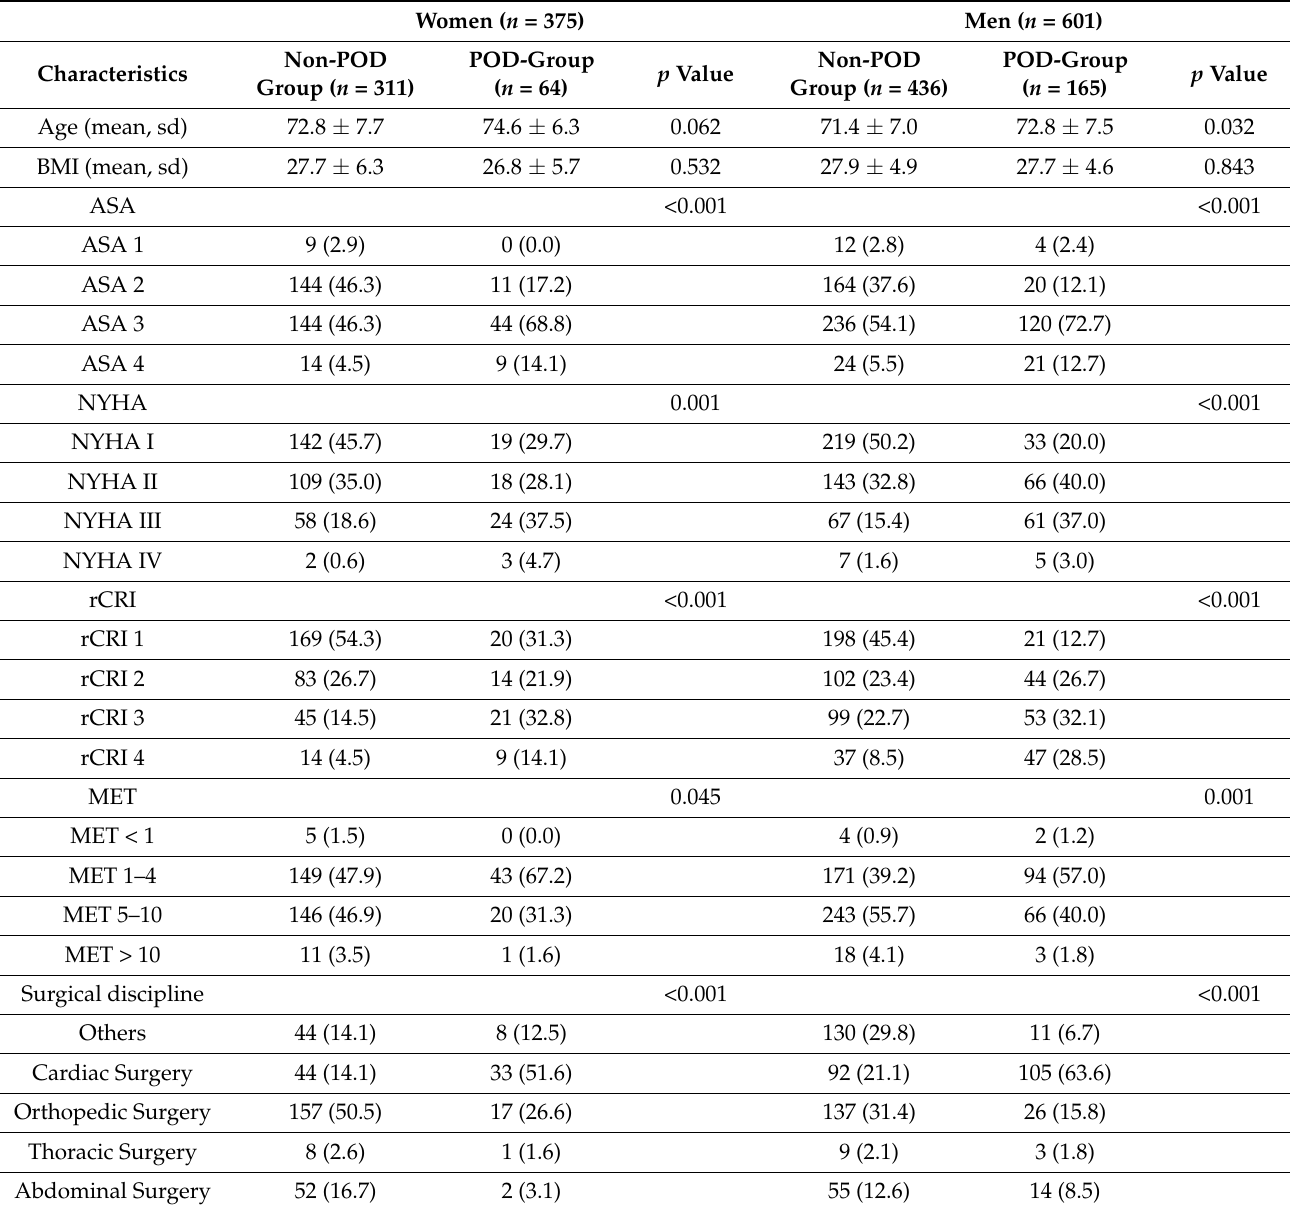
Table 2. Gender specific characteristics in relation to